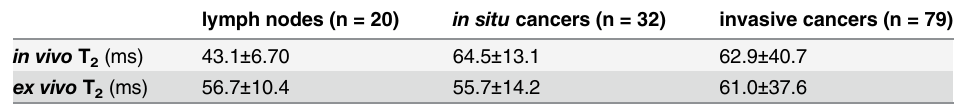
Table 3. The average in vivo and ex vivo T 2 values (mean ± standard deviation) for lymph nodes, in situ cancers, and invasive